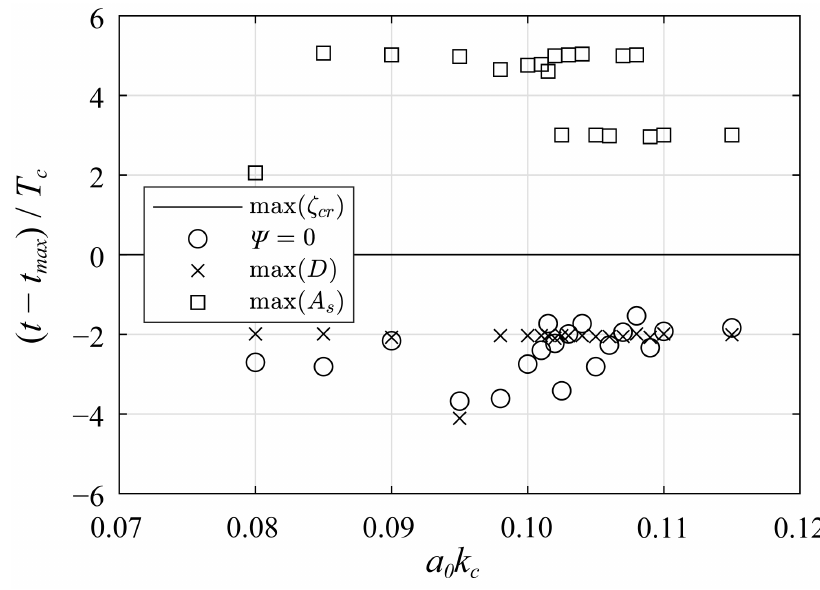
Figure 18. Variations in times of maximum crest height ( ζ cr .), Ψ = 0, maximum degree of phase convergence ( D ), and maximum amplitude sum ( A s ) against initial wave steepness a 0 k c